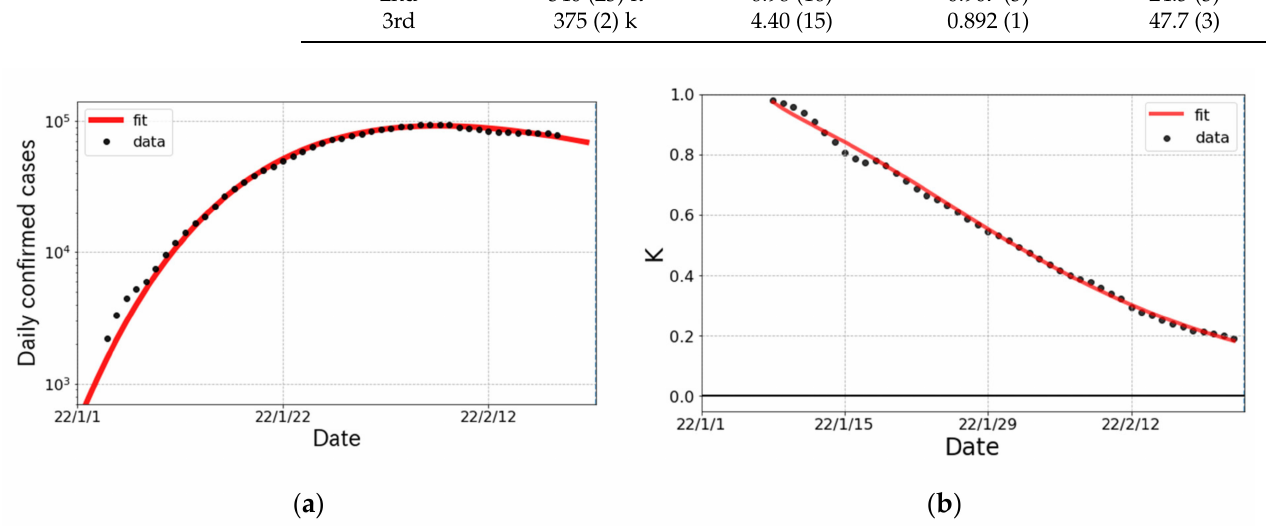
Figure 3. The o surge in Japan from January to February 2022. ( a ) The logarithmic plot of daily confirmed cases (one week average) and fit result. The fit was performed with a single partial wave. ( b ) The observed data and fit result for the